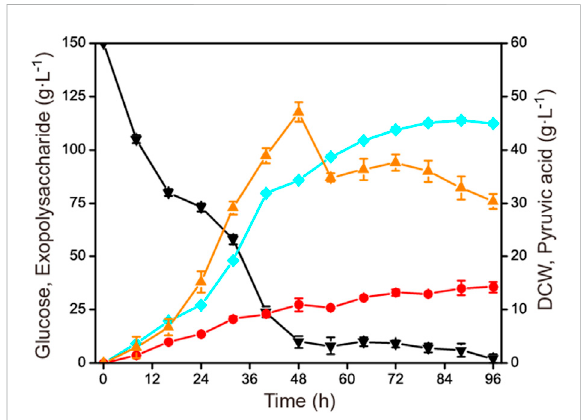
Time course of exopolysaccharide accumulation in a 15-L fermenter. The initial concentration of glucose was 150 g L − 1 , and then 40 g L − 1 glucose was fed constantly during 56 – 84 h. Fermentation was conducted at 30 ° C, 500 rmin − 1 , and 1.0 vvm for 96 h. Black down triangles, glucose; orange up triangles, pyruvic acid; red circles, DCW; blue squares,